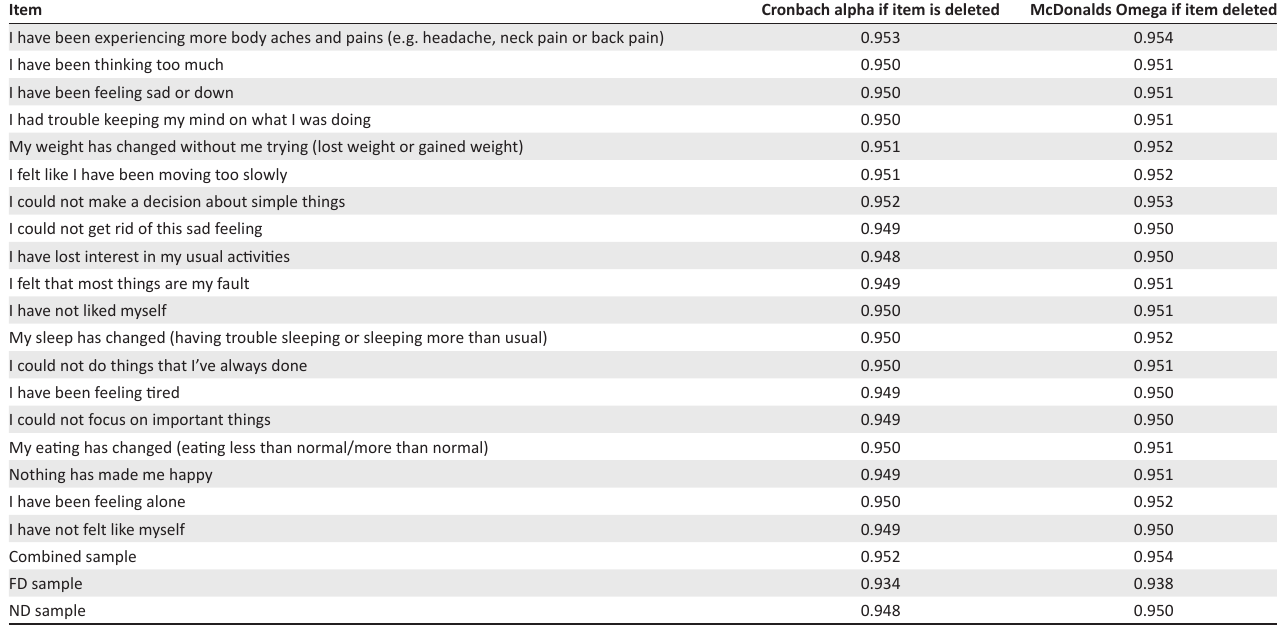
TABLE 4: Reliability